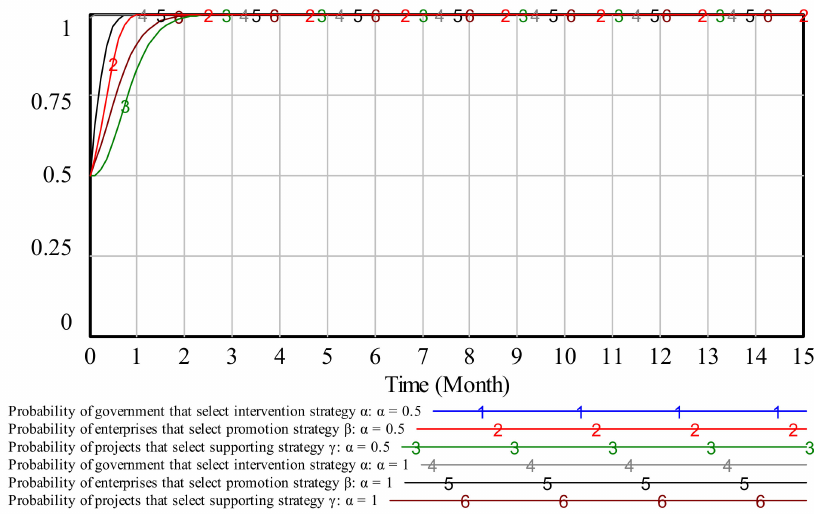
Figure 6. In BAU1, the evolution of enterprises and projects under government